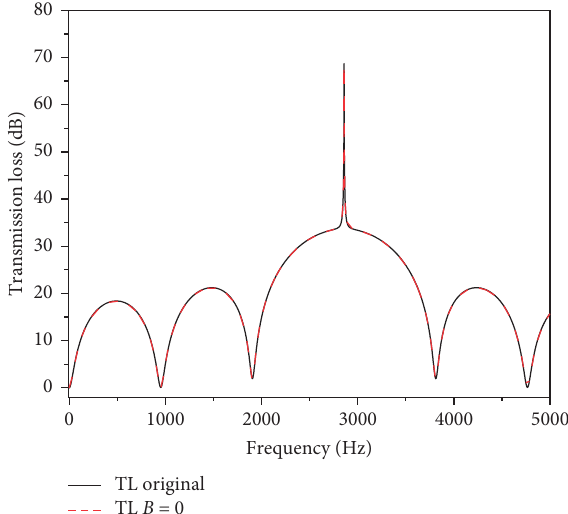
Figure 6: Quadrupole parameter analysis of the side outlet muffler ( D �